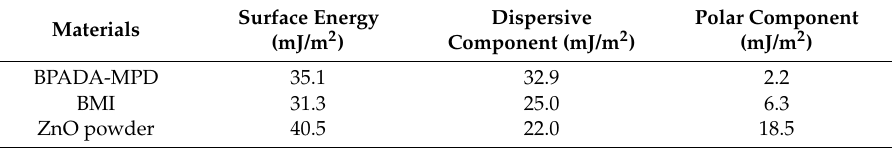
Table 1. Elemental compositions analyzed by WDS in Regions 1 and 2 in Figure 5. Region